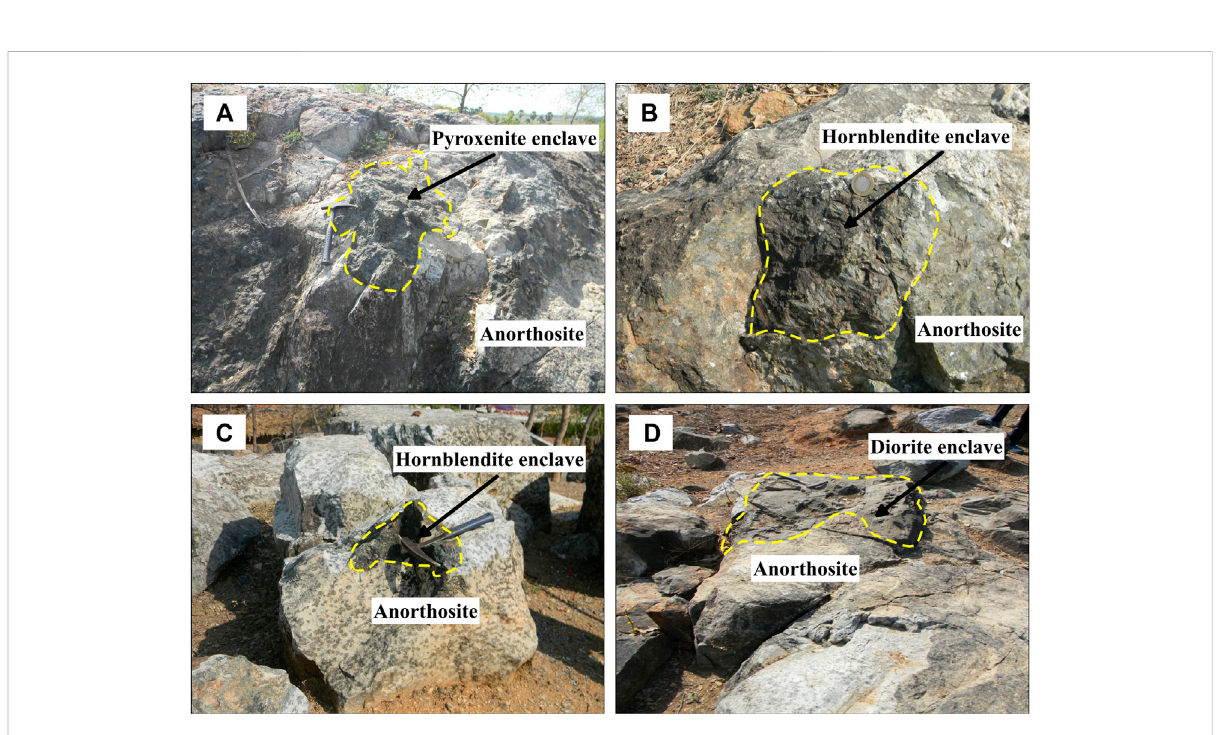
FIGURE 3 Different enclaves found within the anorthosites of the Pattarkatti region (A) pyroxenite enclave (N 24 ° 58 ′ 99.0 ″ , E 85 ° 12 ′ 08.22 ″ ) (B, C) hornblendite enclave (N 24 ° 58 ′ 35.7 ″ , E 85 ° 12 ′ 08.22 ″ ; N 24 ° 58 ′ 99.0 ″ , E 85 ° 12 ′ 08.22 ″ ) (D) diorite enclave (N 24 ° 58 ′ 99.0 ″ , E 85 ° 12 ′ 08.22 ″ ).